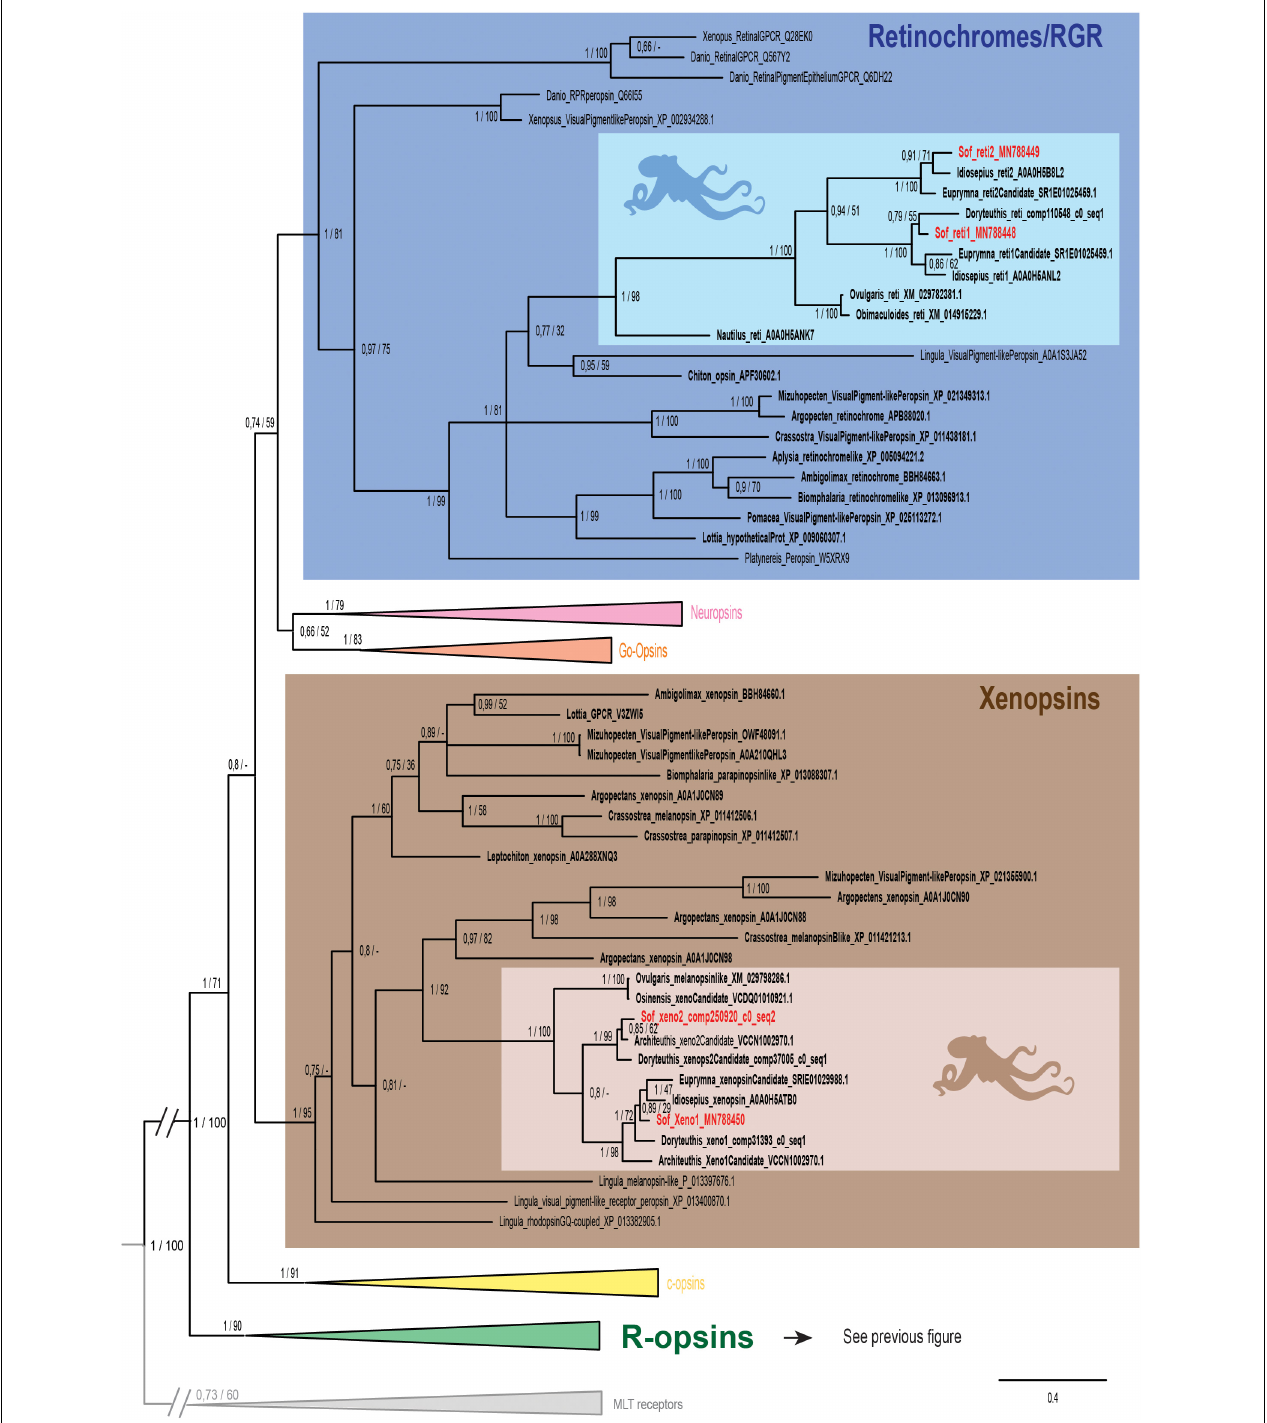
FIGURE 3 | Opsin phylogeny with a focus on retinochromes and xenopsins. Phylogenetic analysis of 139 sequences of 311 amino acids generated in Bayesian Inference (MrBayes v3.2.7a). 6 main groups of opsins are retrieved: retinochromes (blue), neuropsins (red), Go-opsins (orange), xenopsins (brown), c-opsins (yellow) and r-opsins (green). Sequences from S. officinalis are in red, sequences from other molluscs are in bold and outgroups [Melatonine receptors (MLT)] are in gray. Dopamine receptors used for rooting the tree are not shown on the figure. Nodes labels are posterior probabilities and bootstrap values (PP/BS). Lighter boxes with cephalopod silhouette [modified from Stöger et al. (2013)] represent groups of cephalopod sequences. The branch from the root to the ingroups and outgroups were shortened for more lisibility (//).